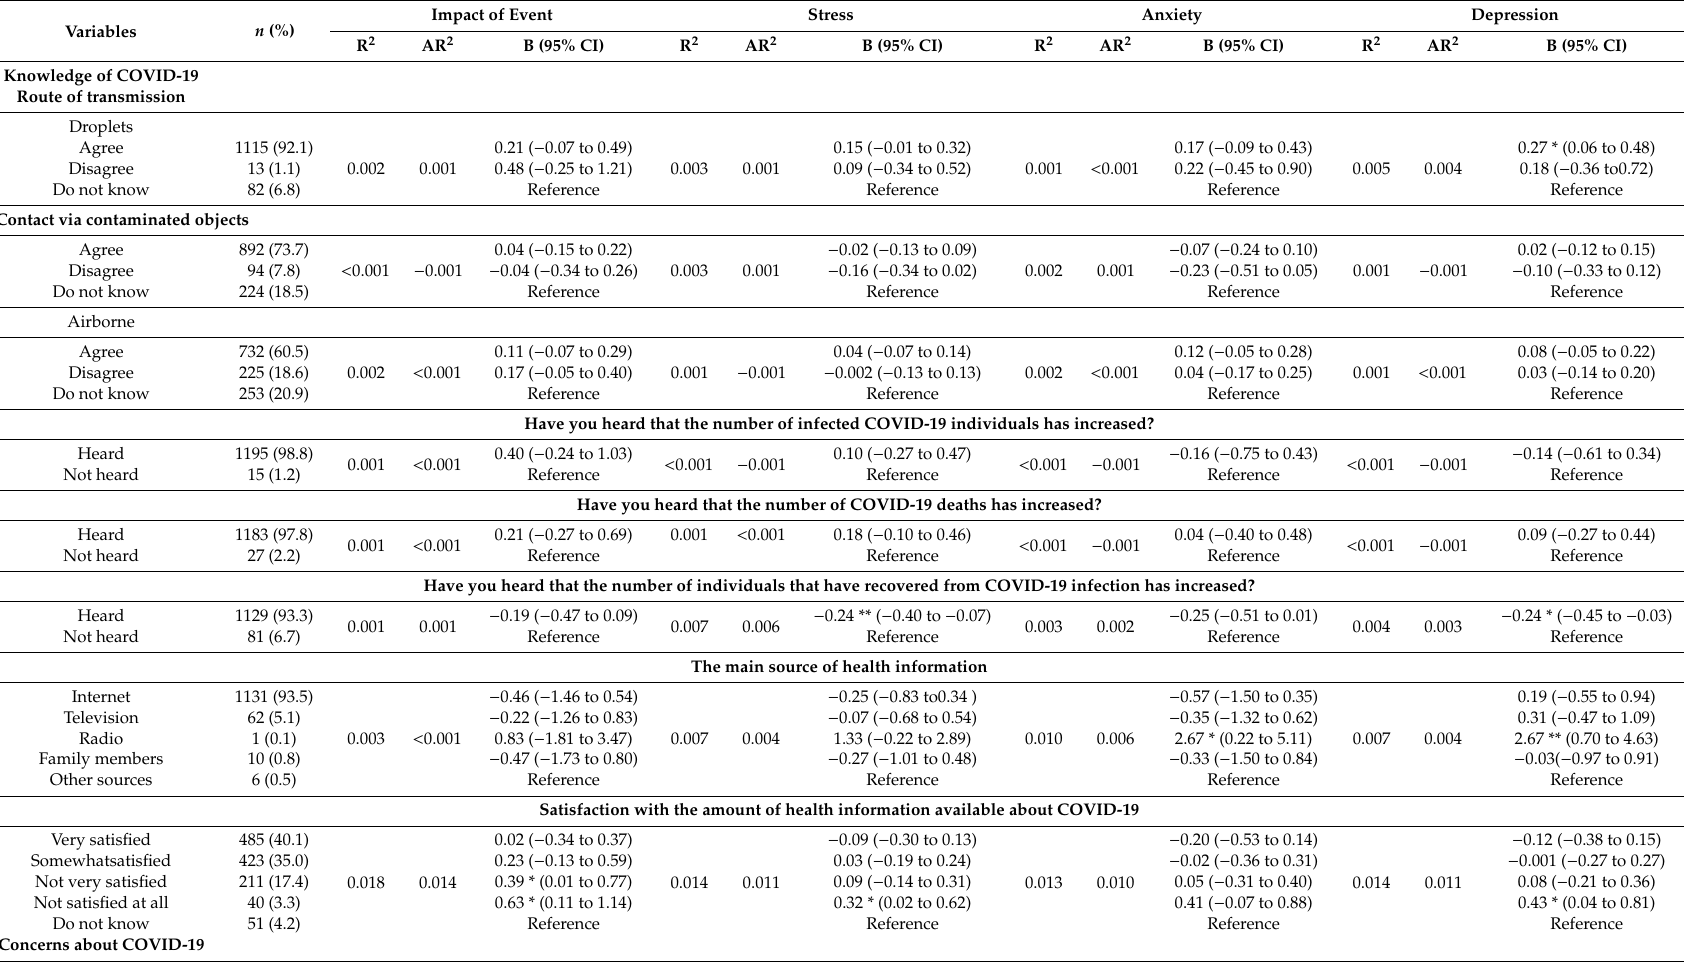
Table 4. Association between knowledge and concerns about the 2019 coronavirus disease (COVID-19) and the psychological impact of outbreak as well as adverse mental health status during the epidemic ( n =